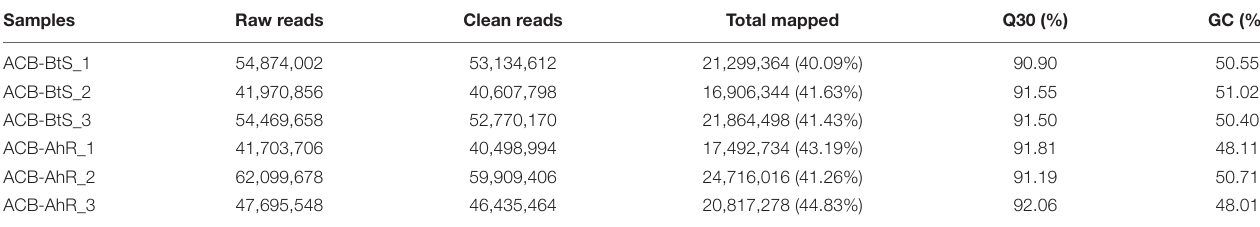
TABLE 1 | Summary of reads in Cry1Ah-resistant strain (ACB-AhR) and susceptible strain (ACB-BtS) of Ostrinia furnacalis transcriptomes.